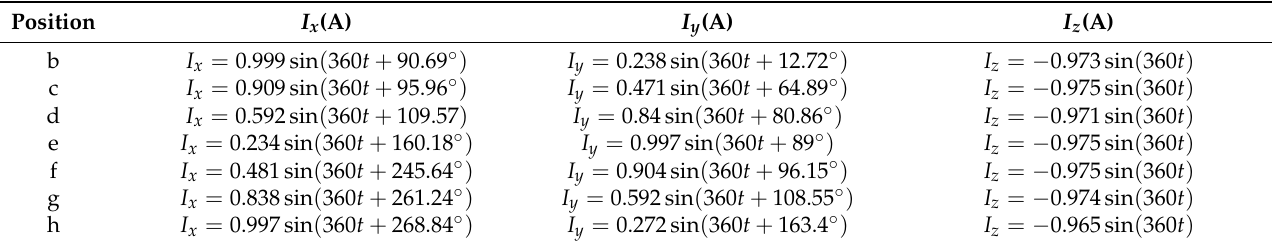
Table 4. Coil current equation corresponding to Figure